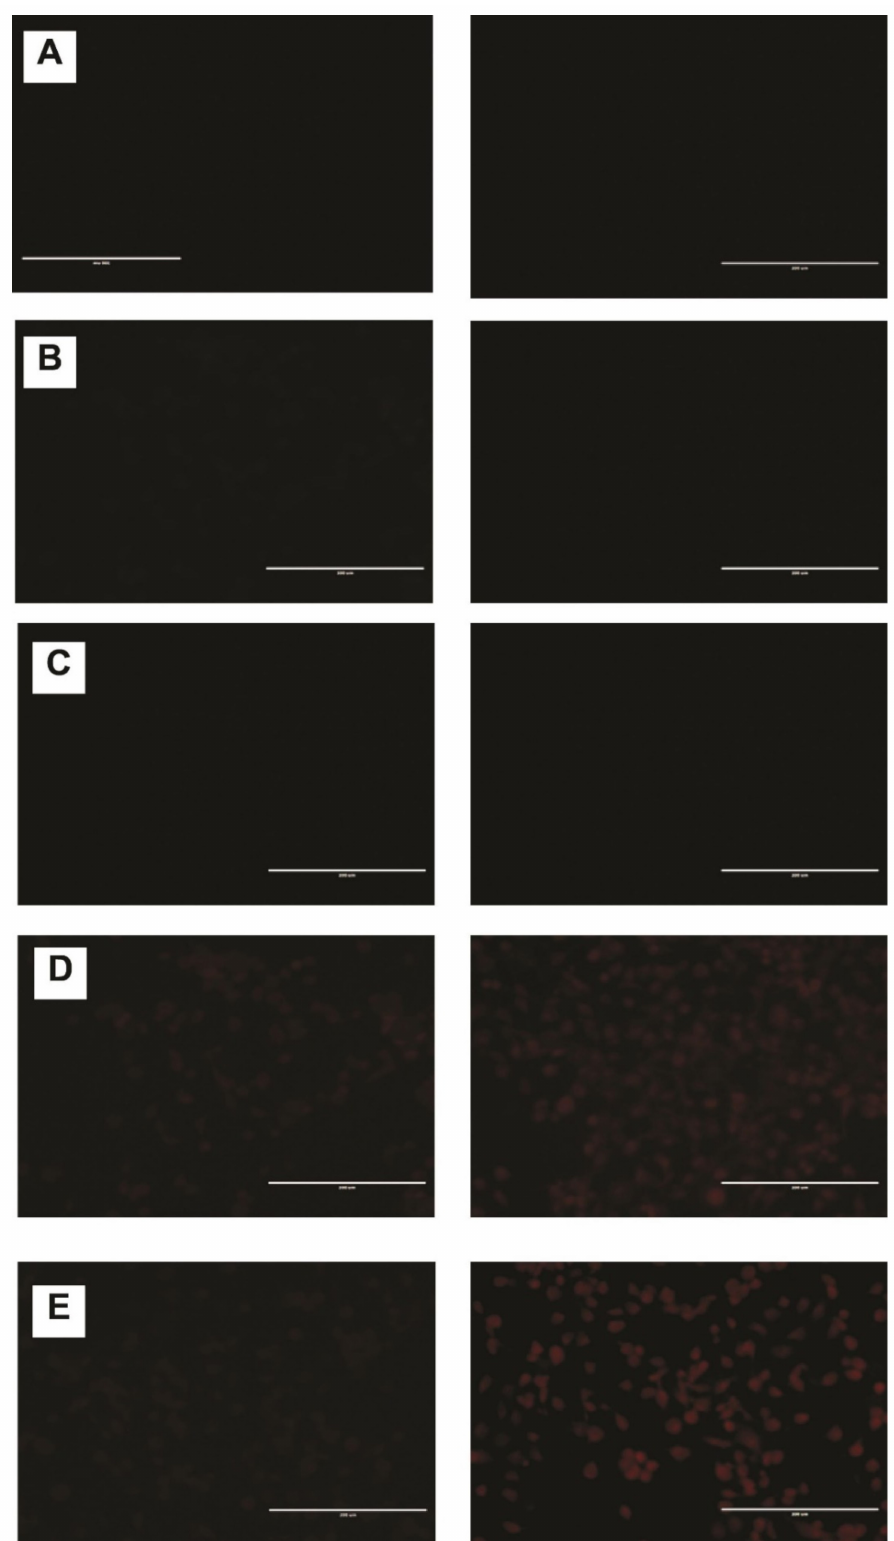
Figure 5. Fluorescence microscopy of different liposomes at 37 ◦ C after 0.5 h ( left ) and 6 h ( right ). MDA-MB-231 cells were cultured for 24 h ( A ) and then were treated with F1 ( B ) F2 ( C ), free DNR ( D ) or F3 ( E ). Final liposomal DNR concentrations were 14 µ M. Scale bar = 200 µ m. Where there is no drug accumulation, the images appear darker with no cell line impressions. TSLs-CL formulation with red color shows DNR